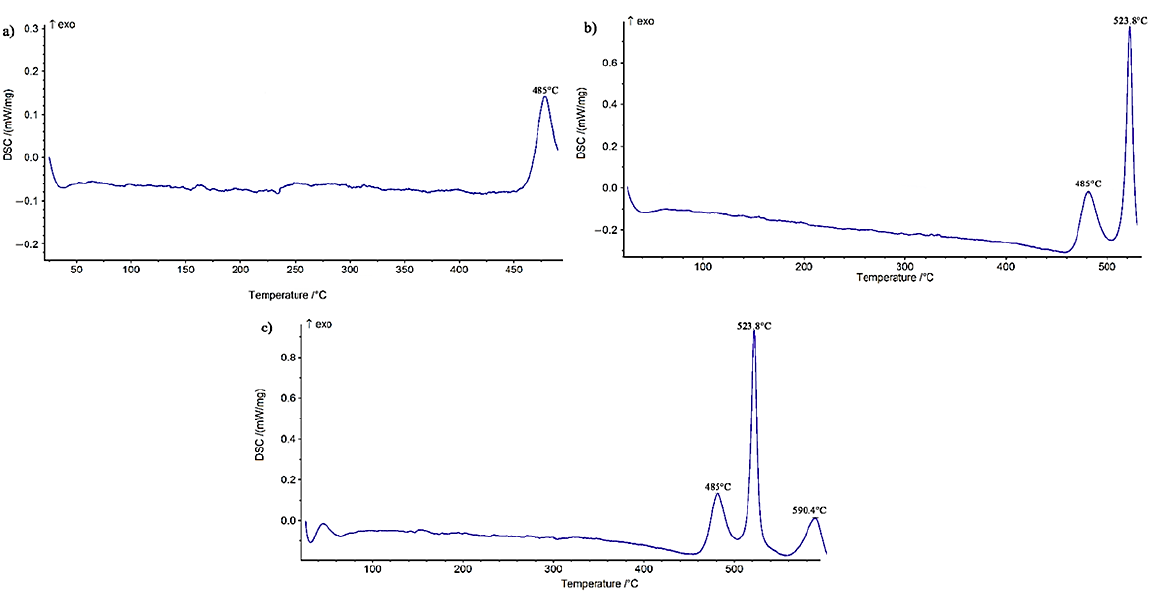
Figure 3. DSC trace of BNi-3 amorphous foil after annealing: ( a ) 490 °C/10 min, ( b ) 530 °C/10 min, and ( c ) 590 °C/10 min.